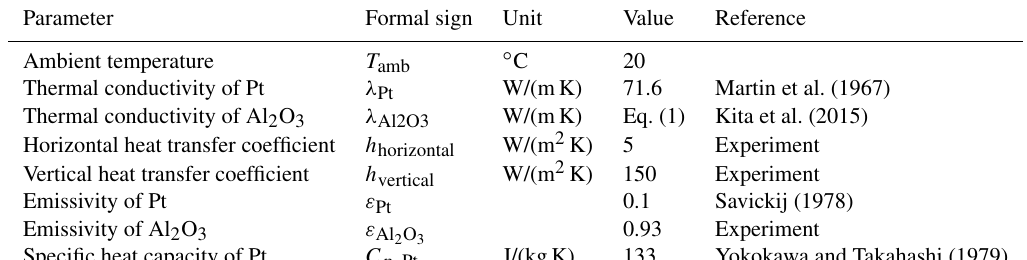
Table 2. Thermal parameters for the COMSOL 3D simulation model.